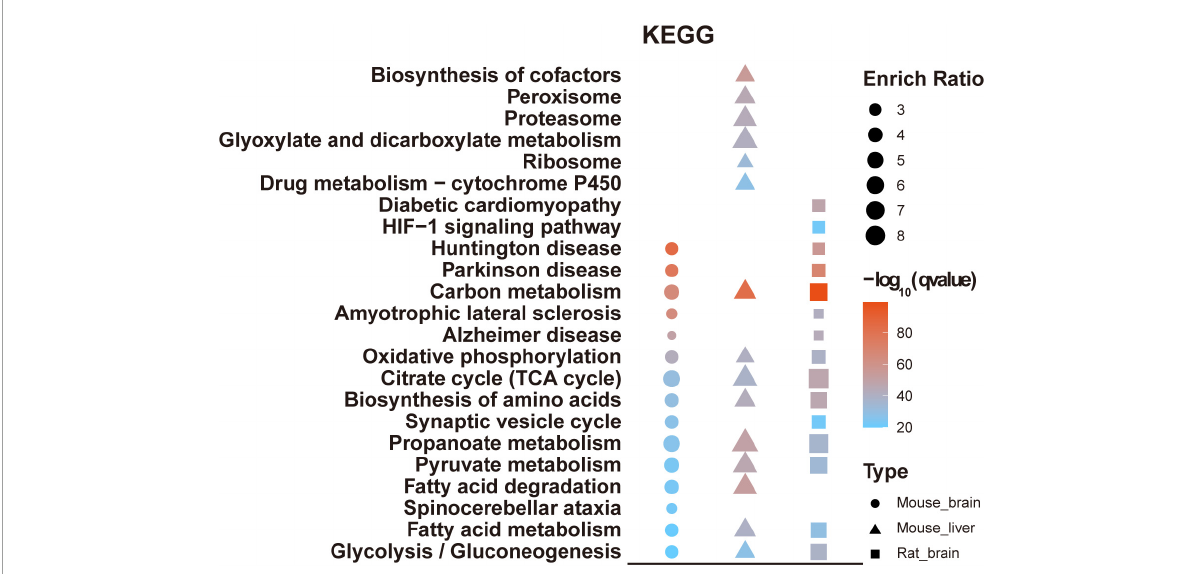
FIGURE6 KEGG analysis of mouse brain acetylome. The KEGG pathway analyzed the mouse brain acetylome and compared it with the rat brain and mouse liver.